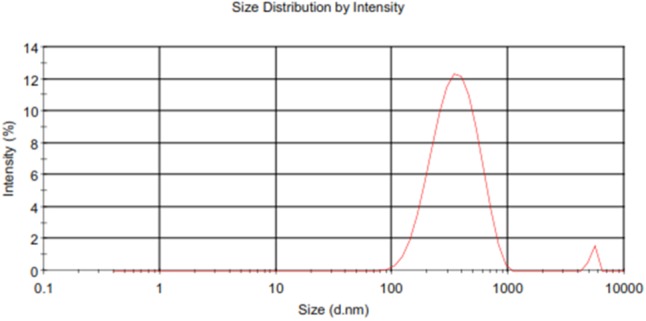
Size distribution of Cur-PLGA nanoparticles.